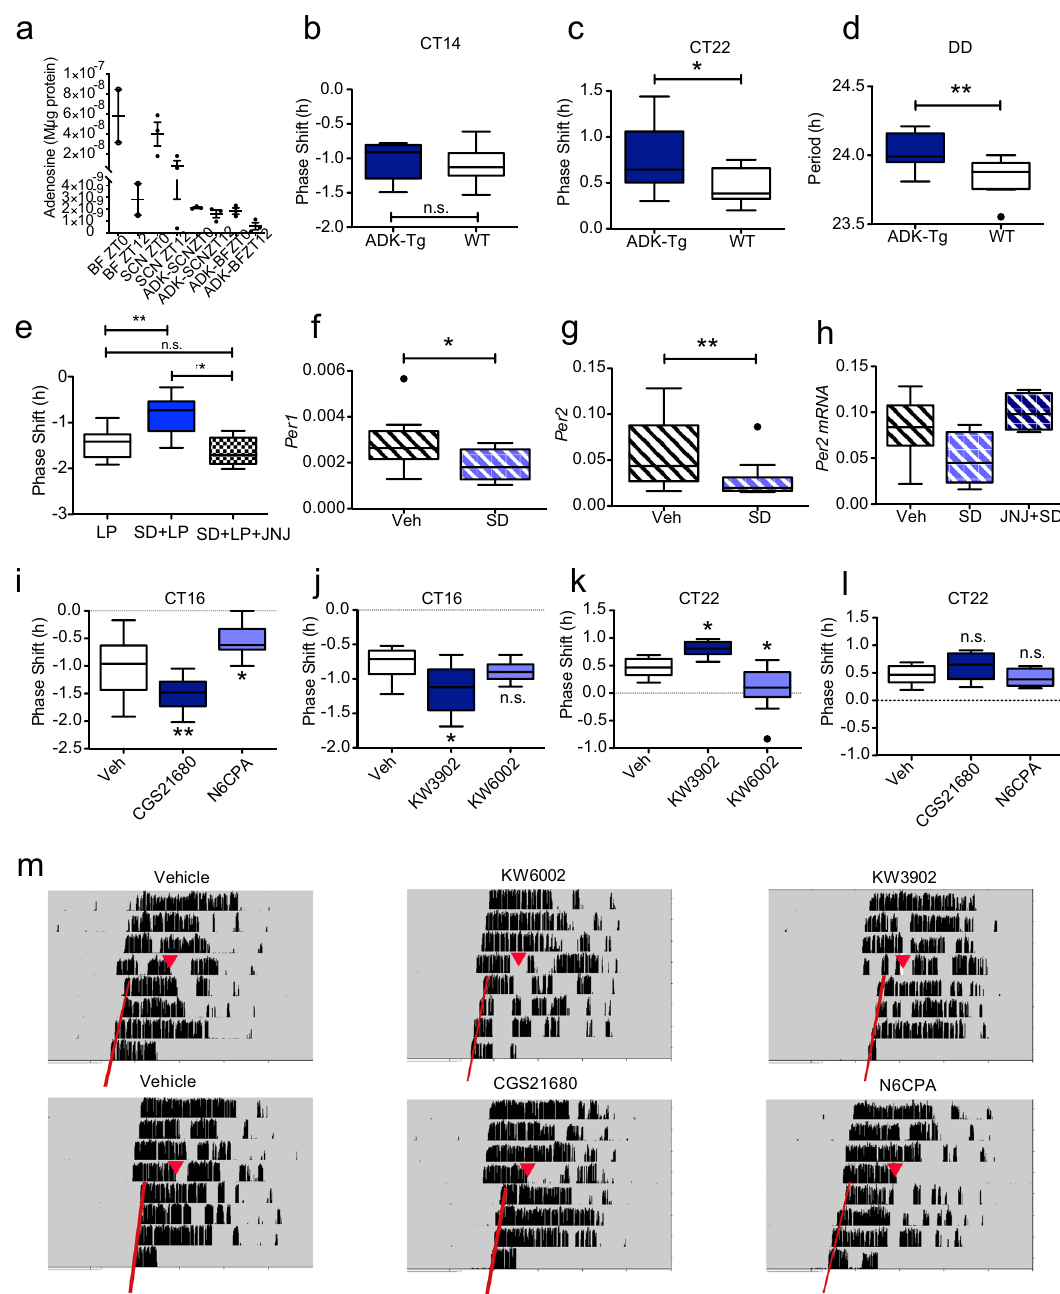
Fig. 5 Altered levels of endogenous adenosine regulate circadian rhythms in vivo. a Basal forebrain (BF) and SCN were collected from wild type and human adenosine kinase overexpressing transgenic mice ( Adk -Tg - ADK) at indicated circadian times. Each sample is a pool of 5 – 7 individual tissue punches. b Phase shifting in Adk -Tg animals (ADK-Tg) and wild type (WT) in response to a 1 h 200 lux light pulse at CT14 ( n = 10 and 9, no signi fi cant difference, t -test) ( b ) and CT22 ( c ) ( n = 14 and 8, p = 0.0439, t -test). d Free running period of the same mice in DD ( n = 12 and 9, p = 0.0071). * = p < 0.05, ** = p < 0.01 t -test. e Behavioural phase-shifts in response to a 30 min 20 lux light pulse (LP) at CT14 ( n = 14) is attenuated by sleep deprivation (SD, n = 10) for the previous 6 h ( p = 0.0001, n = 9 – 11), but potentiated when pretreated with 5 mg/kg JNJ ( n = 9, p = 0.0007) one-way ANOVA with Tukey multiple comparisons. f Sleep deprivation (ZT6-12) reduces the expression of Per1 ( n = 11,11, t -test, p = 0.031) and g Per2 mRNA ( n = 12,12 t -test, p = 0.025) within the SCN. h JNJ (5 mg/kg i.p. administered at ZT6) reverses the attenuation of Per2 within the SCN ( n = 9,11, 8, p = 0.0006, one-way ANOVA with Dunnett ’ s multiple test correction). i – m Behavioural phase shifts in response to light and drugs that modulate adenosine signalling via speci fi c A 1 or A 2A receptor agonists or antagonists: i N6CPA (A 1 agonist, 0.5 mg/kg, p = 0.0164) and CGS21680 (A 2A agonist, 0.5 mg/kg, p = 0.0046) ( n = 12, 9, 13) and j KW3902 (A 1 antagonist, 1 mg/kg, p = 0.0051) and KW6002 (A 2A antagonist, 1 mg/kg) ( n = 11, 9, 11). In i and j the phase-delaying phase shifts induced by a light pulse (30 min, 10 lux) delivered at CT16 are shown. For comparison, the phase-advance induced by a 30 min 100 lux light pulse at CT22 is shown in k ( n = 10, 9, 10) and l ( n = 10, 8, 8) ( p = 0.0188 for KW3902 and p = 0.0078 for KW6002. One-way ANOVA for i – l , Dunnett ’ s multiple test correction. Tukey ’ s box plots used throughout (central line – mean box represents 25 th to 75 th percentile data, whiskers are 1.5 interquartile range). m Representative actograms are shown for i – I